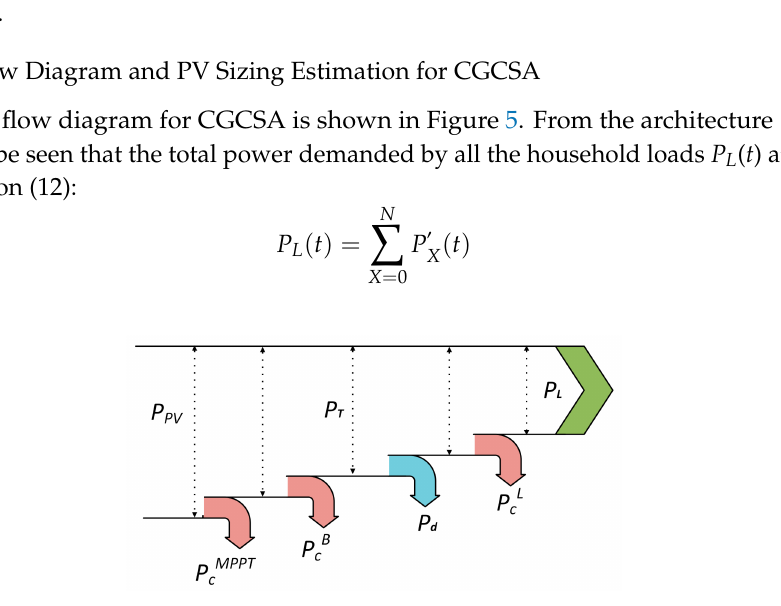
Figure 5. Power flow diagram for central generation and central storage